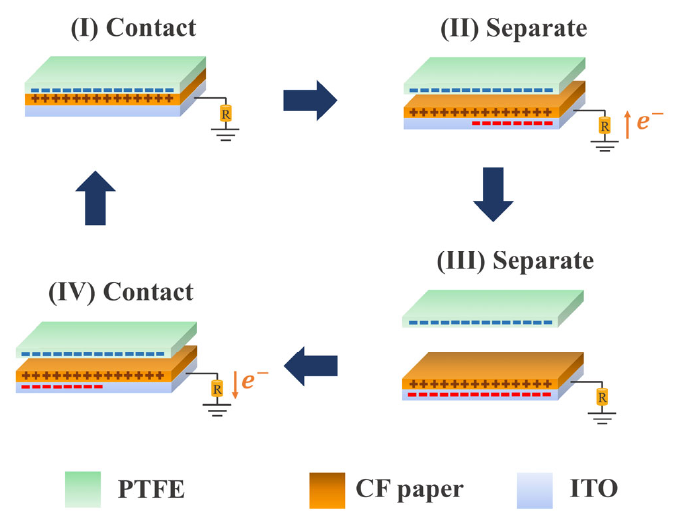
Figure 4. The operation mechanism of CF paper TENG in a single electrode mode.